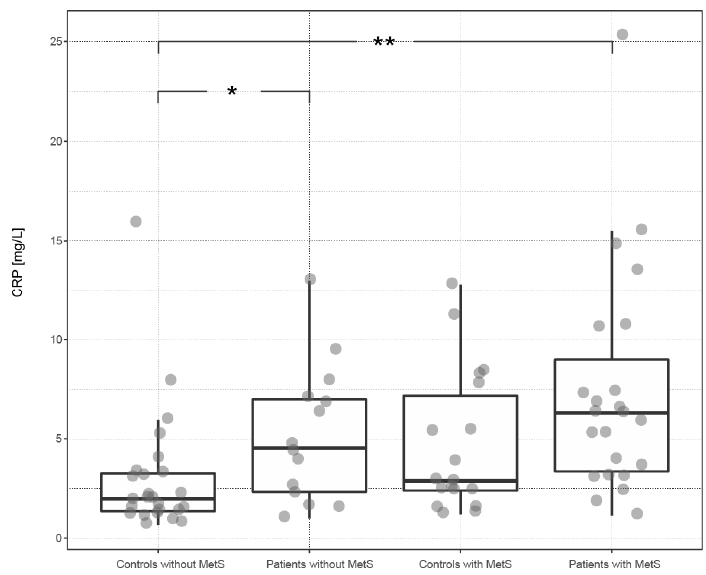
Figure 1. The distribution of CRP (C-reactive protein) among subgroups of subjects defined by the presence of psoriasis and metabolic syndrome. The box plot illustrates the distribution of CRP among subgroups of subjects defined by the presence of psoriasis and MetS (metabolic syndrome). Significant differences are depicted in the upper part of the plot, where * corresponds to p < 0.05 and ** to p < 0.01. For details, see Table 2. In the plot, the lower and upper hinges (first and third quartiles) surround the median of subgroup CRP distribution. The whiskers extend to the largest or smallest value no further than 1.5 times the distance between the first and third quartiles.